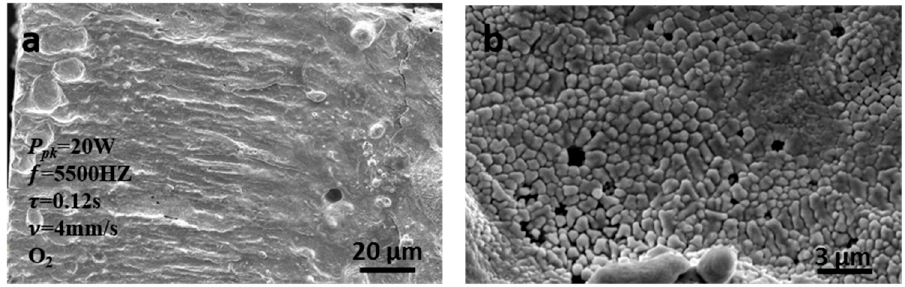
Figure 2. Surface topography of the sample that was cut with oxygen: ( a ) macro view; and ( b ) micro view.